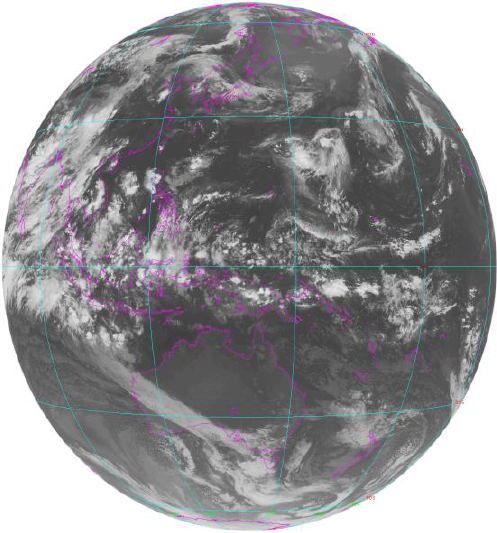
Figure 1. Himawari-8 10.4 µ m satellite image for 21 July 2016 at 1200 UTC.